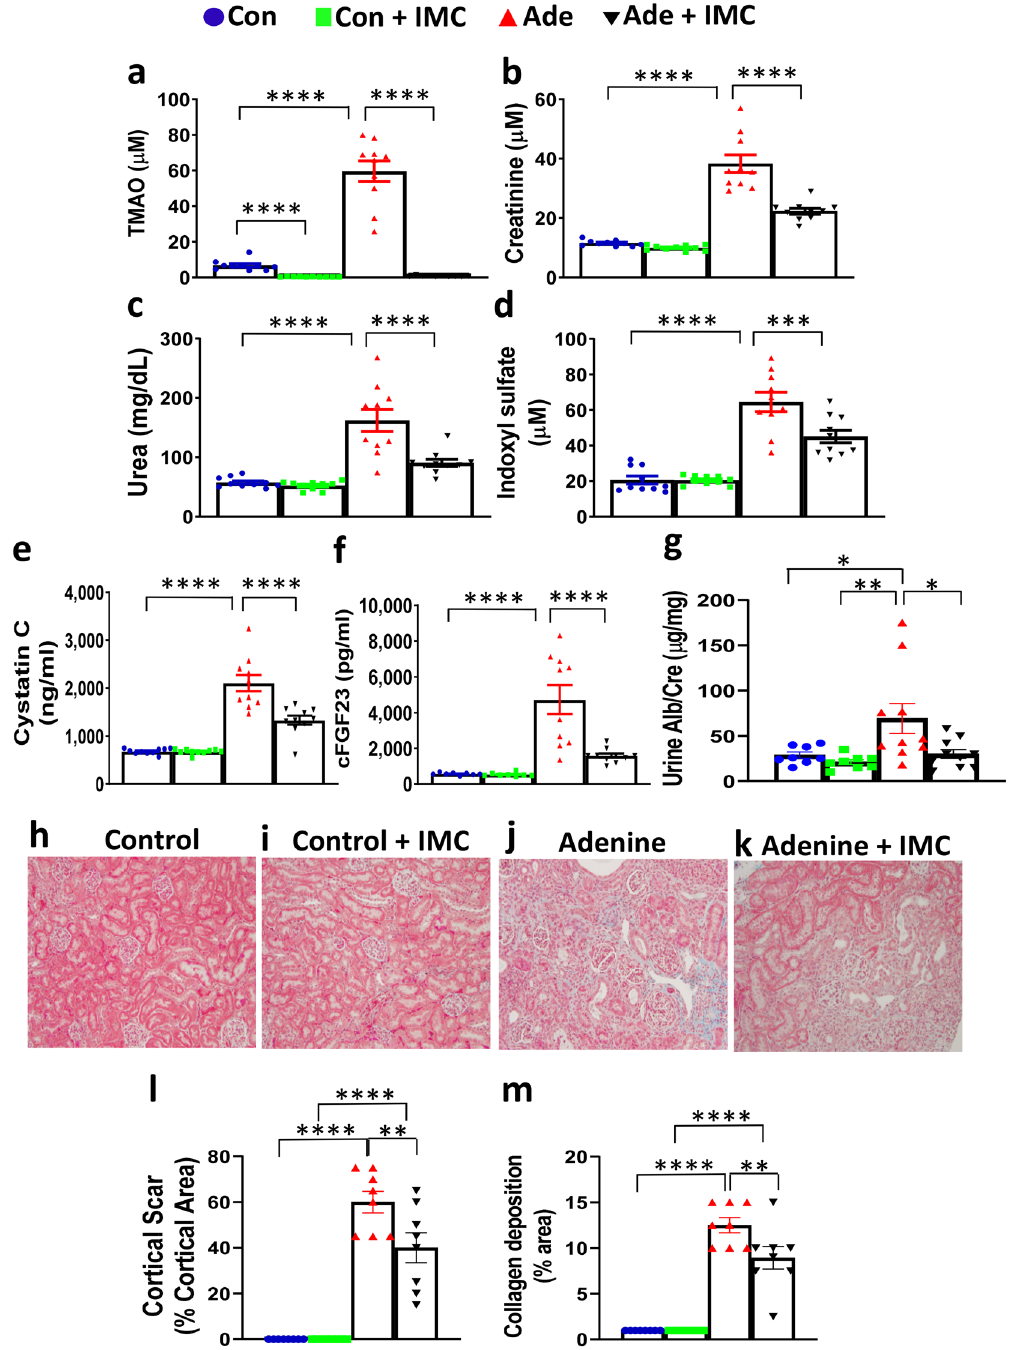
Figure 1. Inhibition of TMAO production attenuates chronic kidney development induced by adenine feeding. Female apoE KO mice (n = 10 per group) were fed control (Con), control + IMC (Con + IMC), adenine (Ade), or adenine + IMC (Ade + IMC) diets for 14 weeks before measurements of traits. Plasma levels of ( a ) TMAO, ( b ) creatinine, ( c ) Urea, ( d ) Indoxyl sulfate, ( e ) Cystatin C, and ( f ) c-terminal FGF23 (cFGF23) are shown. ( g ) Urine albumin (Alb) to creatinine (Cre) ratios are shown. Representative kidney sections stained with Masson’s trichrome are shown in ( h – k ). Quantification of kidney pathology, ( l ) cortical scar, and ( m ) collagen deposition, in the kidney sections of all 4 groups are shown. Individual values, means, and standard errors are shown. Sample sizes were n = 10/group for ( a – f ), n = 8–10/group for ( g ), and n = 8 kidneys/group for ( l , m ). For ( a – f , l , m ), post hoc multiple comparisons analysis was performed after significant two-way ANOVA. Symbols: *p < 0.05, **p < 0.01, ***p < 0.001, and ****p <